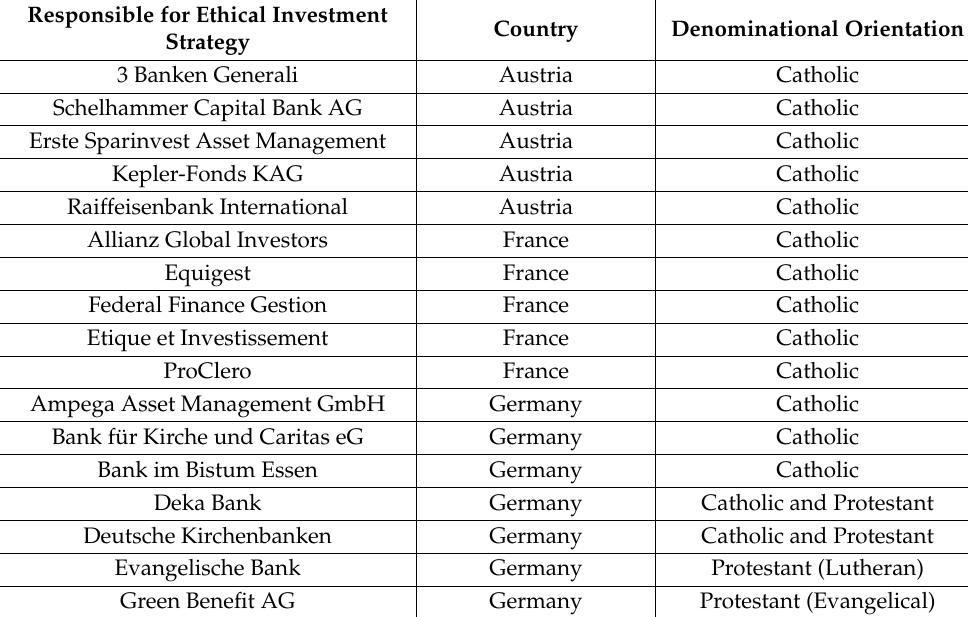
Table A1. Overview of all CIF